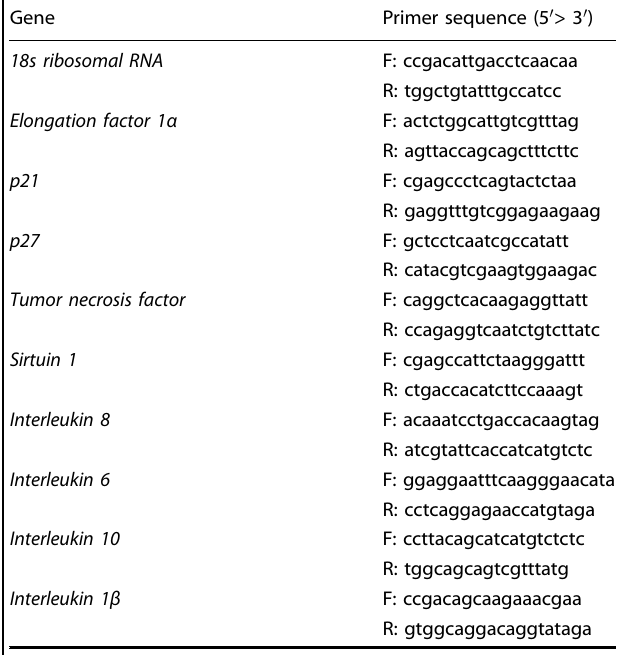
Table 1. List of primer sequences used for RT-qPCR analysis. Gene Primer sequence (5 ′ > 3 ′